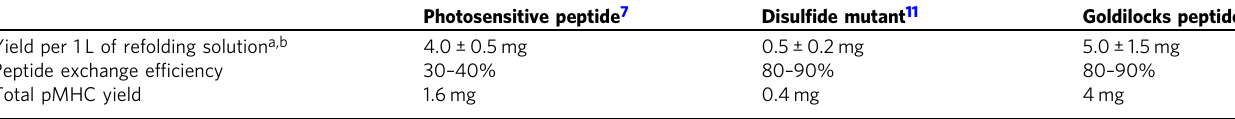
Table 1 Comparison of ef fi ciencies between different peptide exchange